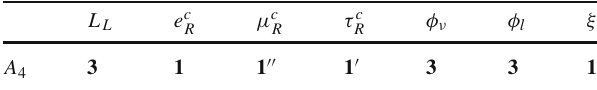
Table 1 Relevant field and A 4 symmetry content from